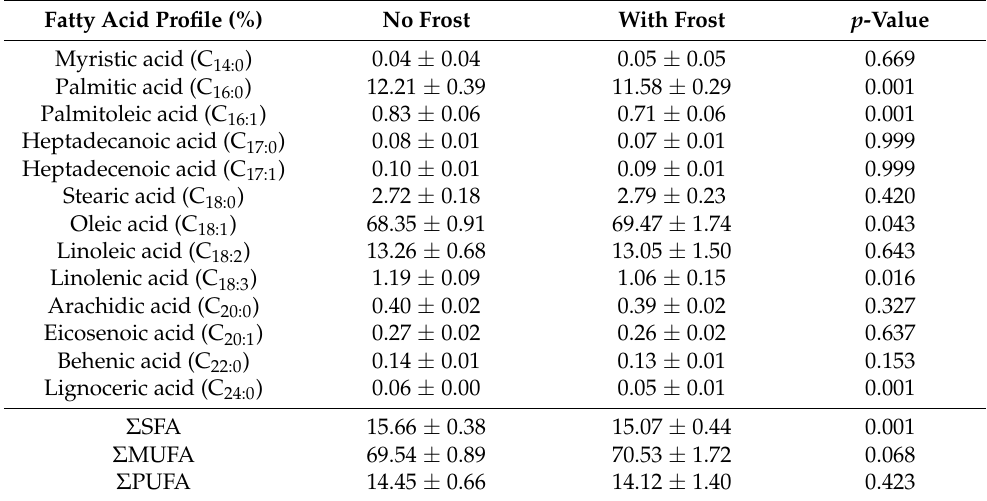
Table 2. Fatty acids profile (%) of olives from cv . Santulhana subjected or not to frost (mean ± standard